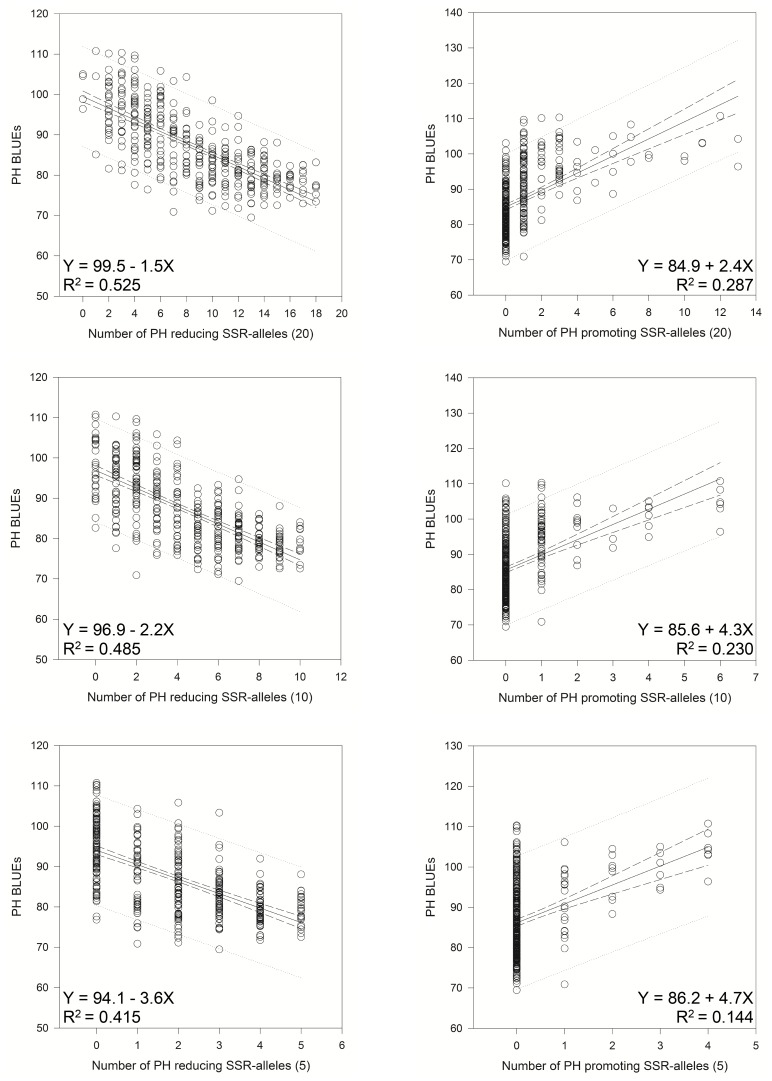
Linear regressions of the most PH reducing (“best”) and the most PH promoting (“worst”) SSR-alleles with PH-BLUEs.Linear regression resulted in a relationship between PH-BLUEs and the 20, 10 or 5 “best” or “worst” SSR-alleles in 372 varieties.